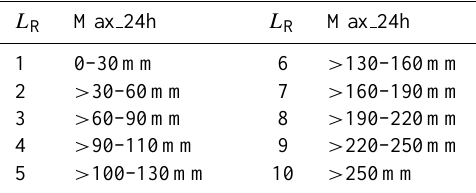
Table 3. Classification of Maximum Rainfall into different